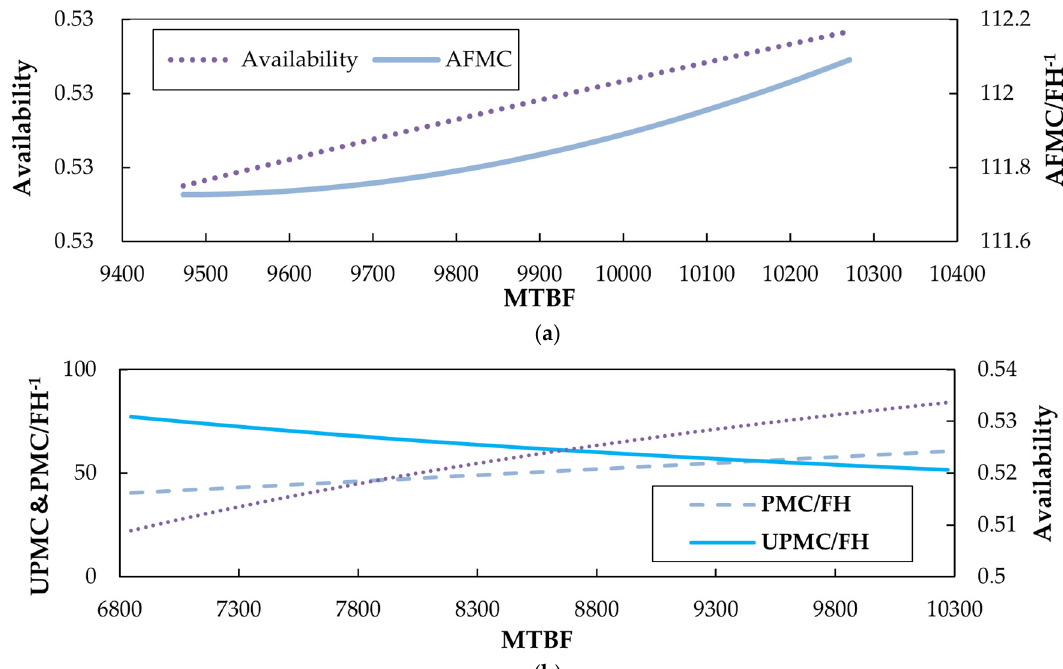
Figure 6. Convergence of objective function. ( a ) Dual-objective model iteration results; ( b ) Three-